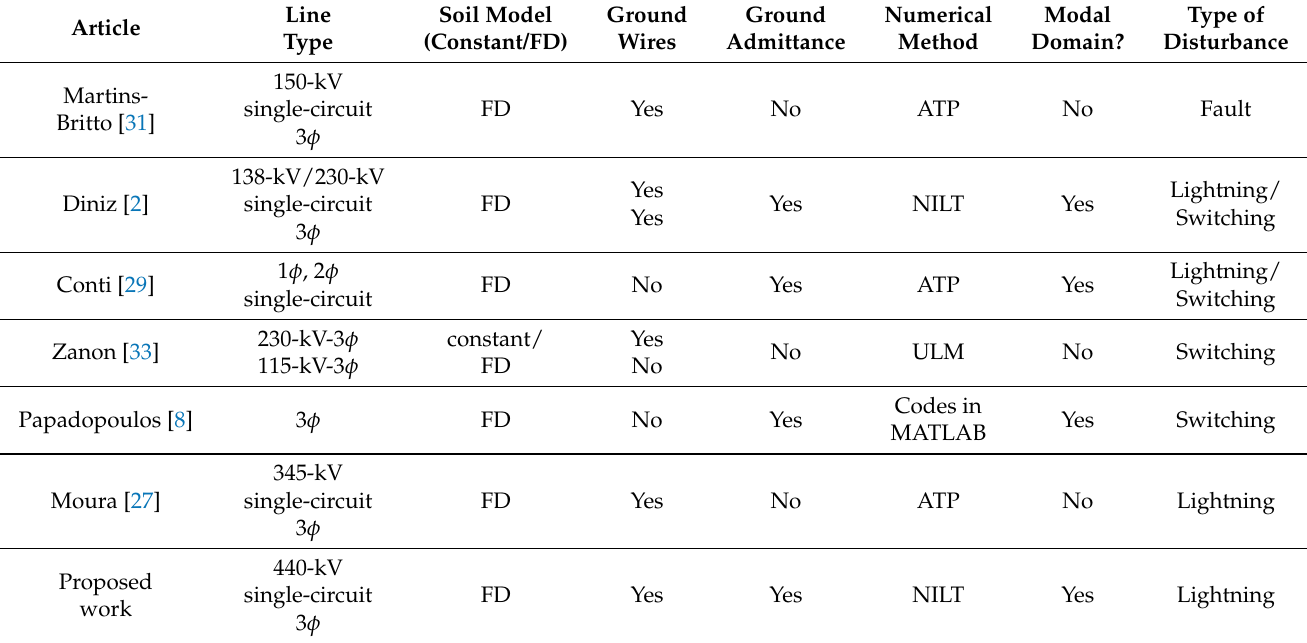
Table 1. Comparison between some articles in the literature and the proposed